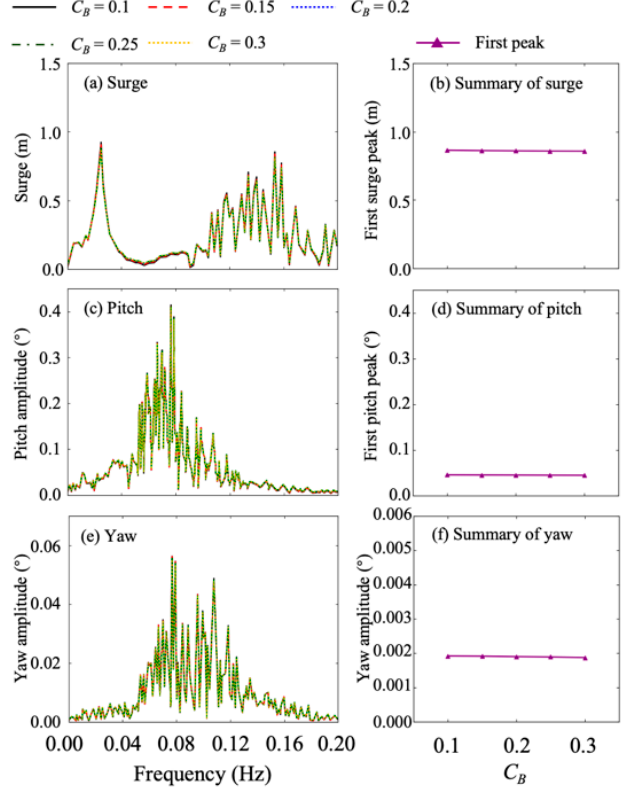
Figure 19. Wind turbine surge, pitch, and yaw movements with different static friction coefficients when under irregular wave case C6: ( a , b ) surge movement; ( c , d ) pitch movement; ( e , f ) yaw movement.